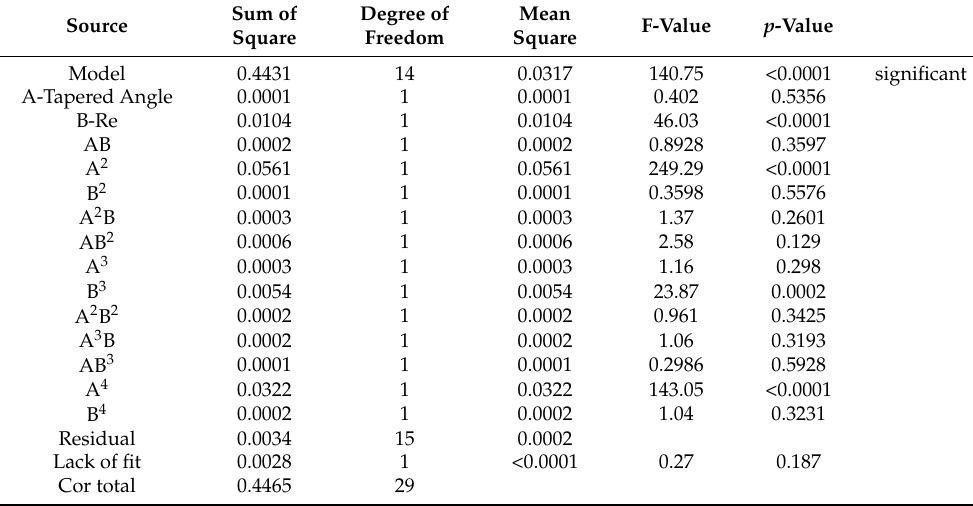
Table 5. Optimization results for the inlet tapered header.